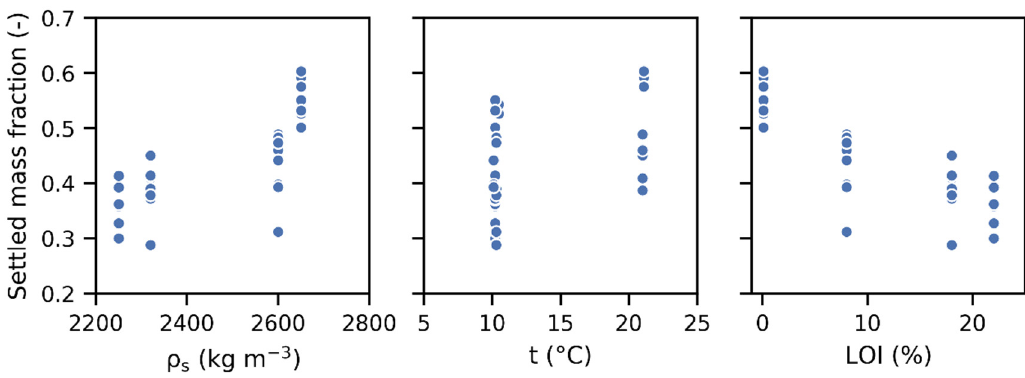
Figure 4. Settled mass fraction in the settling experiments with respect to ρ s , t, and LOI; n = 33.